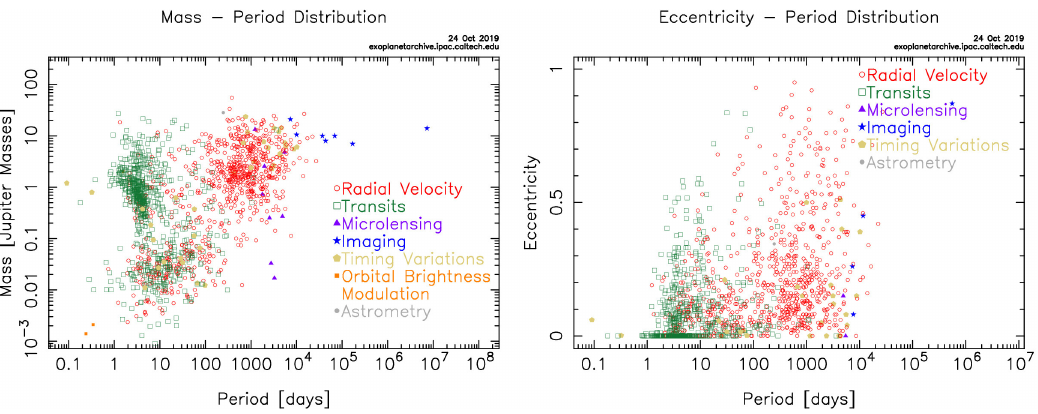
Figure 22. Distribution of characteristics of exoplanets (from NASA Exoplanet Archive [267]). Colors represent different detection methods. Left panel: mass plotted against orbital period. Right panel: eccentricity plotted against orbital period. Most of the planets in the solar system have orbits that are almost circular ( (cid:101) ∼ 0). Exoplanets, however, show a wide range of eccentricities. A number of multi-planet systems has been detected (see Figure